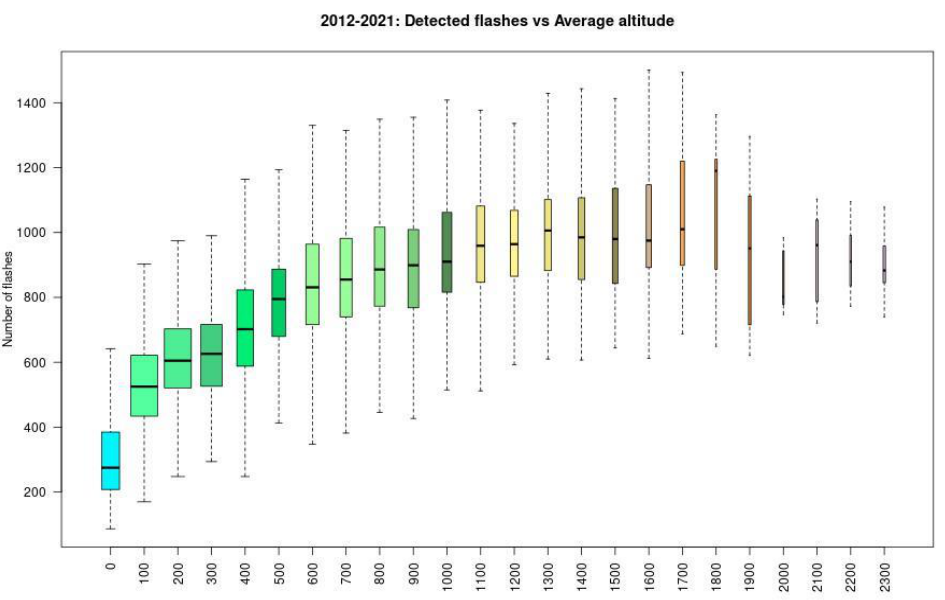
Figure 11. Box and whiskers plot of the number of detected flashes for the period 2012 — 2021 as a function of the average (on the grid of 0.05 × 0.05 deg) height in km.